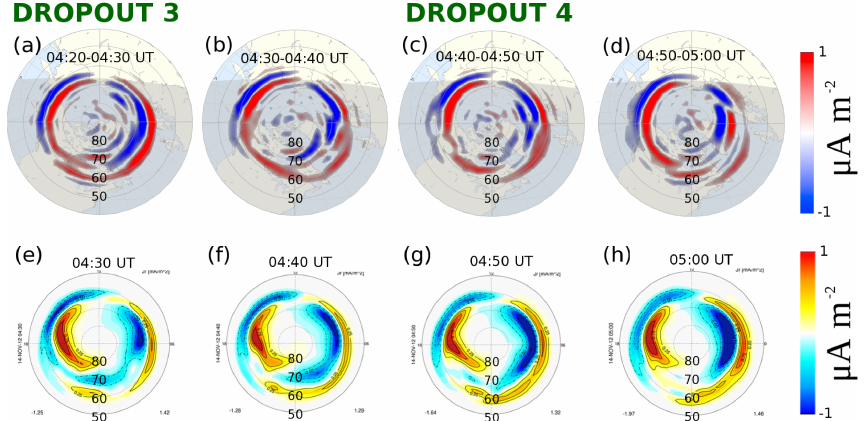
Figure 5. AMPERE-derived Birkeland currents and model Birkeland currents sampled to reflect dynamics before, during, and after dropouts 3 and 4. The format is the same as for Fig.